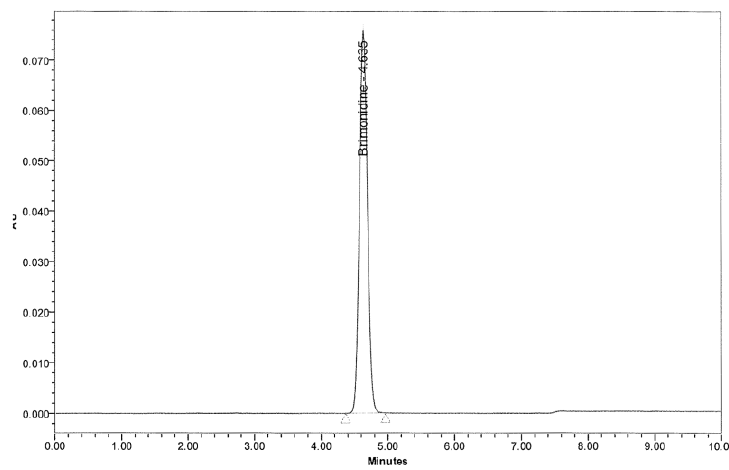
Figure 2 . Typical Chromatogram of Brimonidine by HPLC (20μg/mL). The peak area of the above solutions was recorded and a Calibration graph was plotted by taking the concentration on the x-axis and the corresponding peak area of Brimonidine on the y-axis. A straight line was obtained passing through the origin (Figure 3).